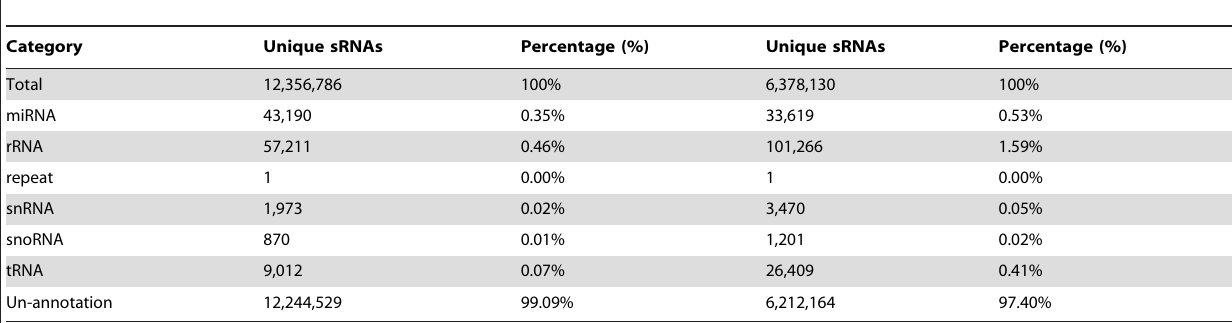
Table 1. Category distribution of small RNAs in root tissues of Oncidium orchid 6 P. indica